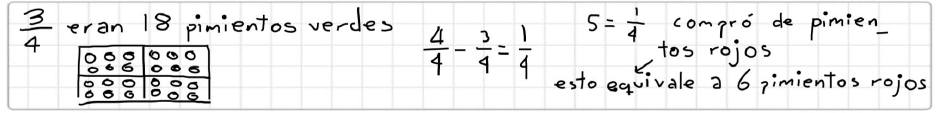
Figure 2. PT21’s written answer to problem FWP2. (Translation of PT21’s solution: “504 cans will remain unsold.”). Figure 4. PT94’s written answer to problem FWP1. (Translation of PT94’s solution: “¾ were green Figure 3. PT94’s written answer to problem FWP1. (Translation of PT94’s solution: “ 3 peppers. Solution: He bought ¼ of red peppers. This is equivalent to 6 red peppers.”). peppers. Solution: He bought 1 of red peppers. This is equivalent to 6 red 4